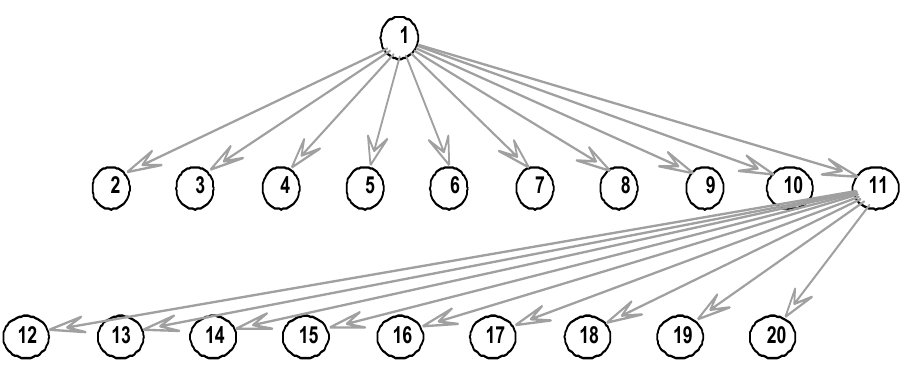
Figure 4. DBN structure of STII prediction under MATLAB.